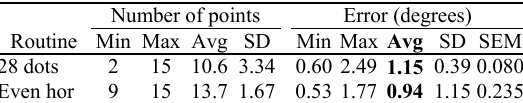
Average number of validation points that was included and the average error (over participants and validation targets) for each of the calibration routines. (SD: Standard deviation, SEM: Standard error of the mean) Number of points Error Routine